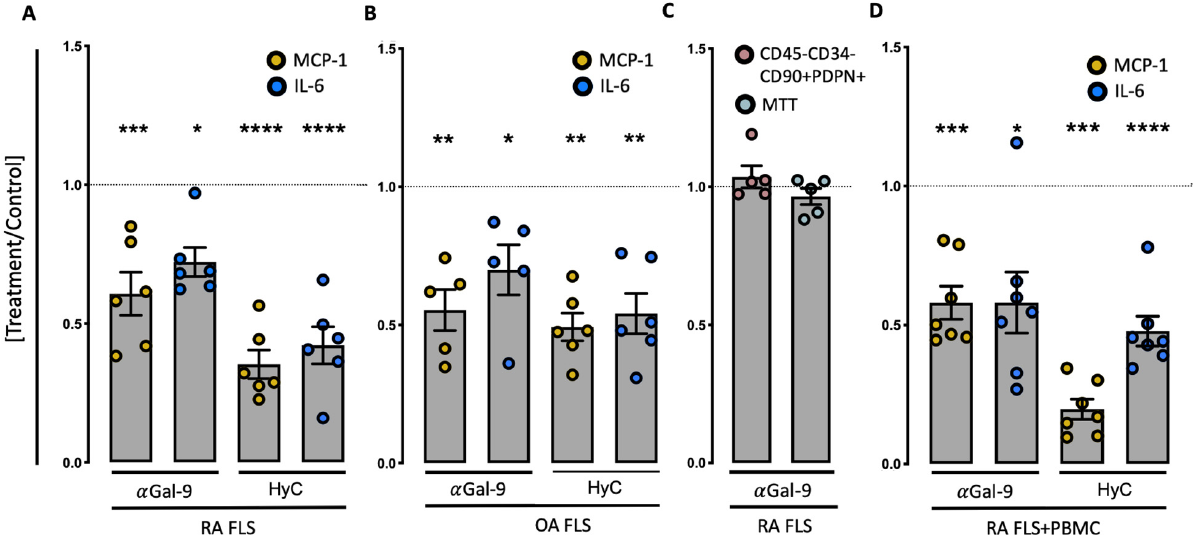
Figure 3. The secretion of MCP-1 and IL-6. Results are expressed as ratios of the cytokine concentrations in neutralizing Gal-9, (Gal-Nab2, 10 µg/mL) and Hydrocortisone (HyC) (1 µg/mL)-treated monocultures of fibroblast-like synovial cells (FLS), divided by the concentration in control cultures, cultured for 48 h (RA n = 6), (OA (HyC, n = 6), (Gal-Nab2, n = 5)). ( C ) Evaluation of pathological FLSs and viability (MTT values) of the anti-Gal-9 treated cells in ( A ) and ( B ). FLSs incubated with the neutralizing anti-Gal-9 antibody. Data are expressed as ratios between the pro- portion of pathological FLSs (CD45-, CD34-, CD90+, and PDPN+) out of all CD45-FLS incubation with the neutralizing anti-Gal-9 antibody or isotype control IgG ( n = 5), or the ratio between mTT ODs of all FLSs incubated with anti-Gal-9 or isotype control IgG ( n = 5); in both set-ups the cells were cultured for 48 h. ( D ) Secretion of MCP-1 and IL-6 from 48 h RA FLSs + PBMC co-cultures. Data are expressed as ratios between the cytokine concentrations in neutralizing Gal-9, (Gal-Nab2, 10 µ g/mL) and Hydrocortisone (HyC) (1 µ g/mL)-treated co-cultures of fibroblast-like synovial cells (FLSs) + autologous PBMCs, divided by the concentration in control-treated cultures, cultured for 48 h (RA n = 7). Differences were analyzed using the paired t -tests to compare two groups. Untreated RA co-cultures of FLSs + autologous PBMCs produced, on average, 30,055 ± 4063 pg/mL MCP-1 and 44,624 ± 5006 pg/mL IL-6 (Mean ± SEM). Bars indicate mean ± SEM. * p < 0.05, ** p < 0.01, *** p < 0.001, **** p <